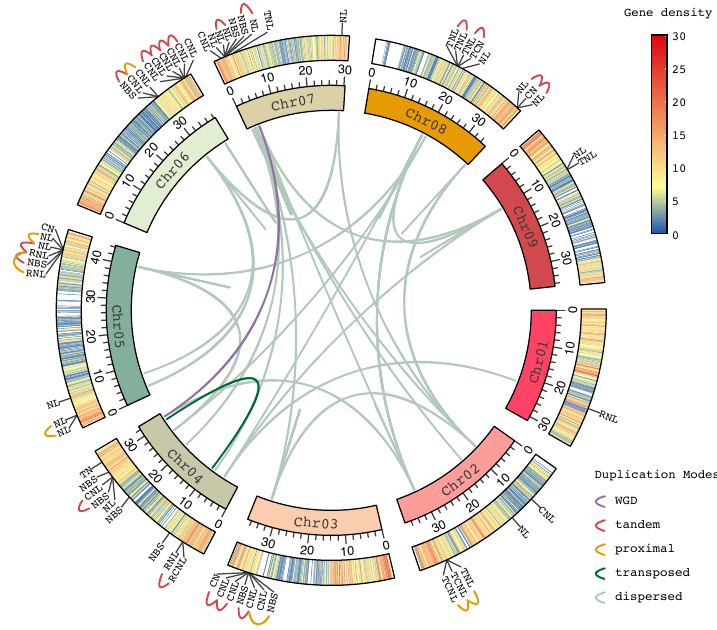
Figure 3. Physical locations and duplication modes of NLRs in papaya